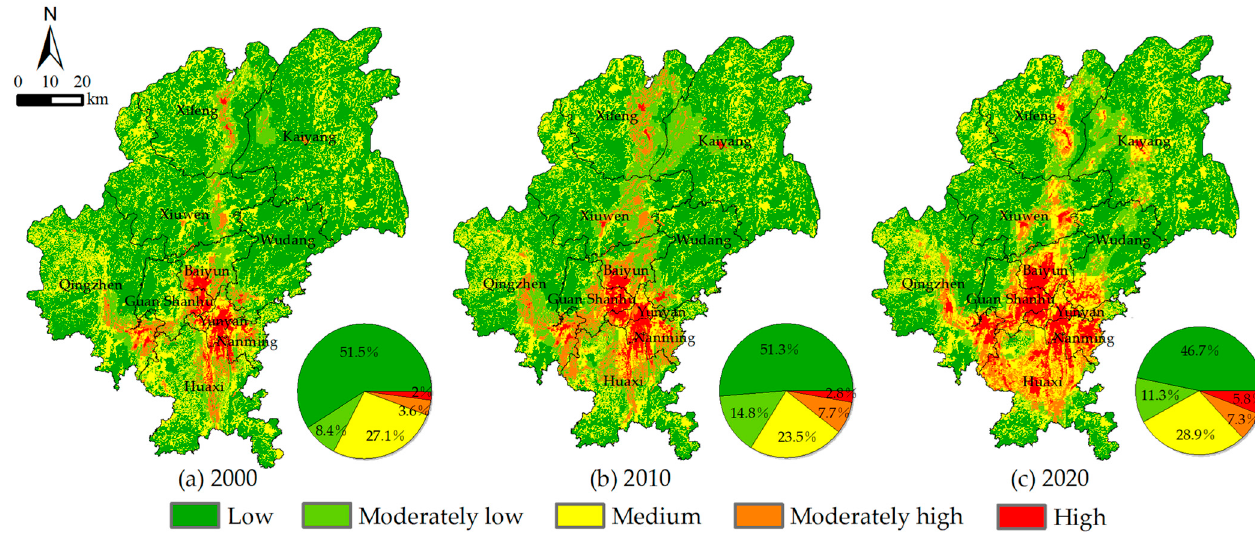
Figure 7. Spatio-temporal patterns of human footprint in Guiyang city from 2000 to Figure 7. Spatio ‐ temporal distribution of human footprint in Guiyang city from 2000 to 2020.